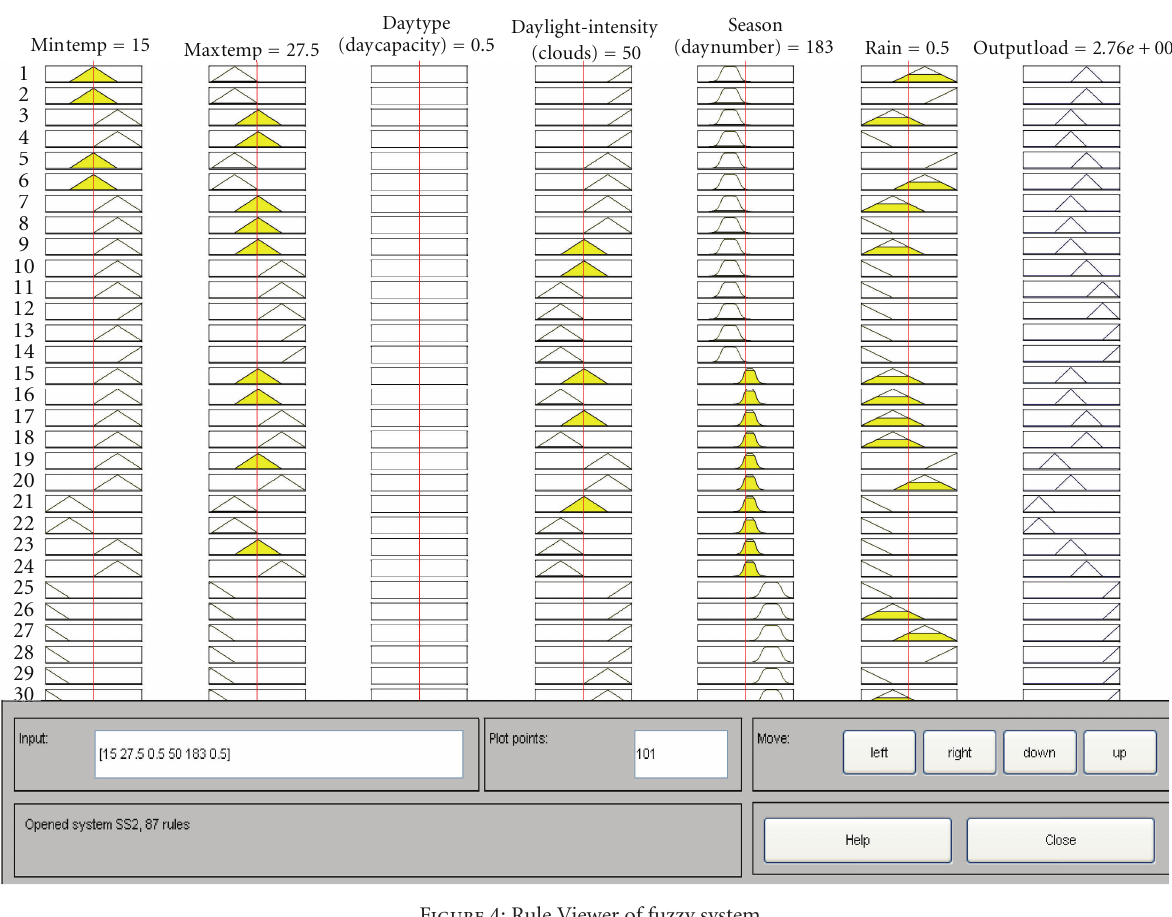
Figure 4: Rule Viewer of fuzzy system.